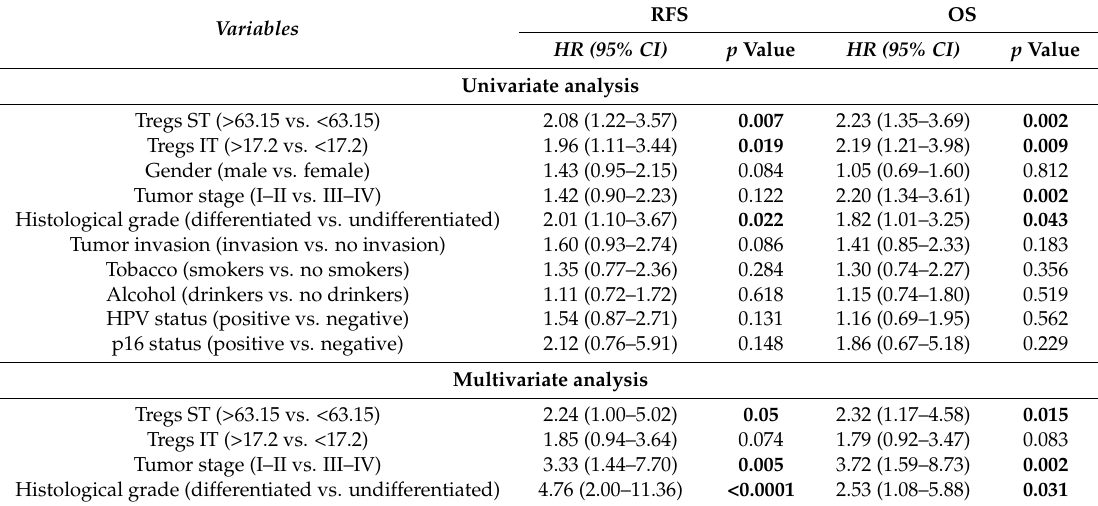
Table 2. Correlation between patient clinical data and recurrence-free (RFS) and overall survivals (OS). p values < 0.05 are highlighted in